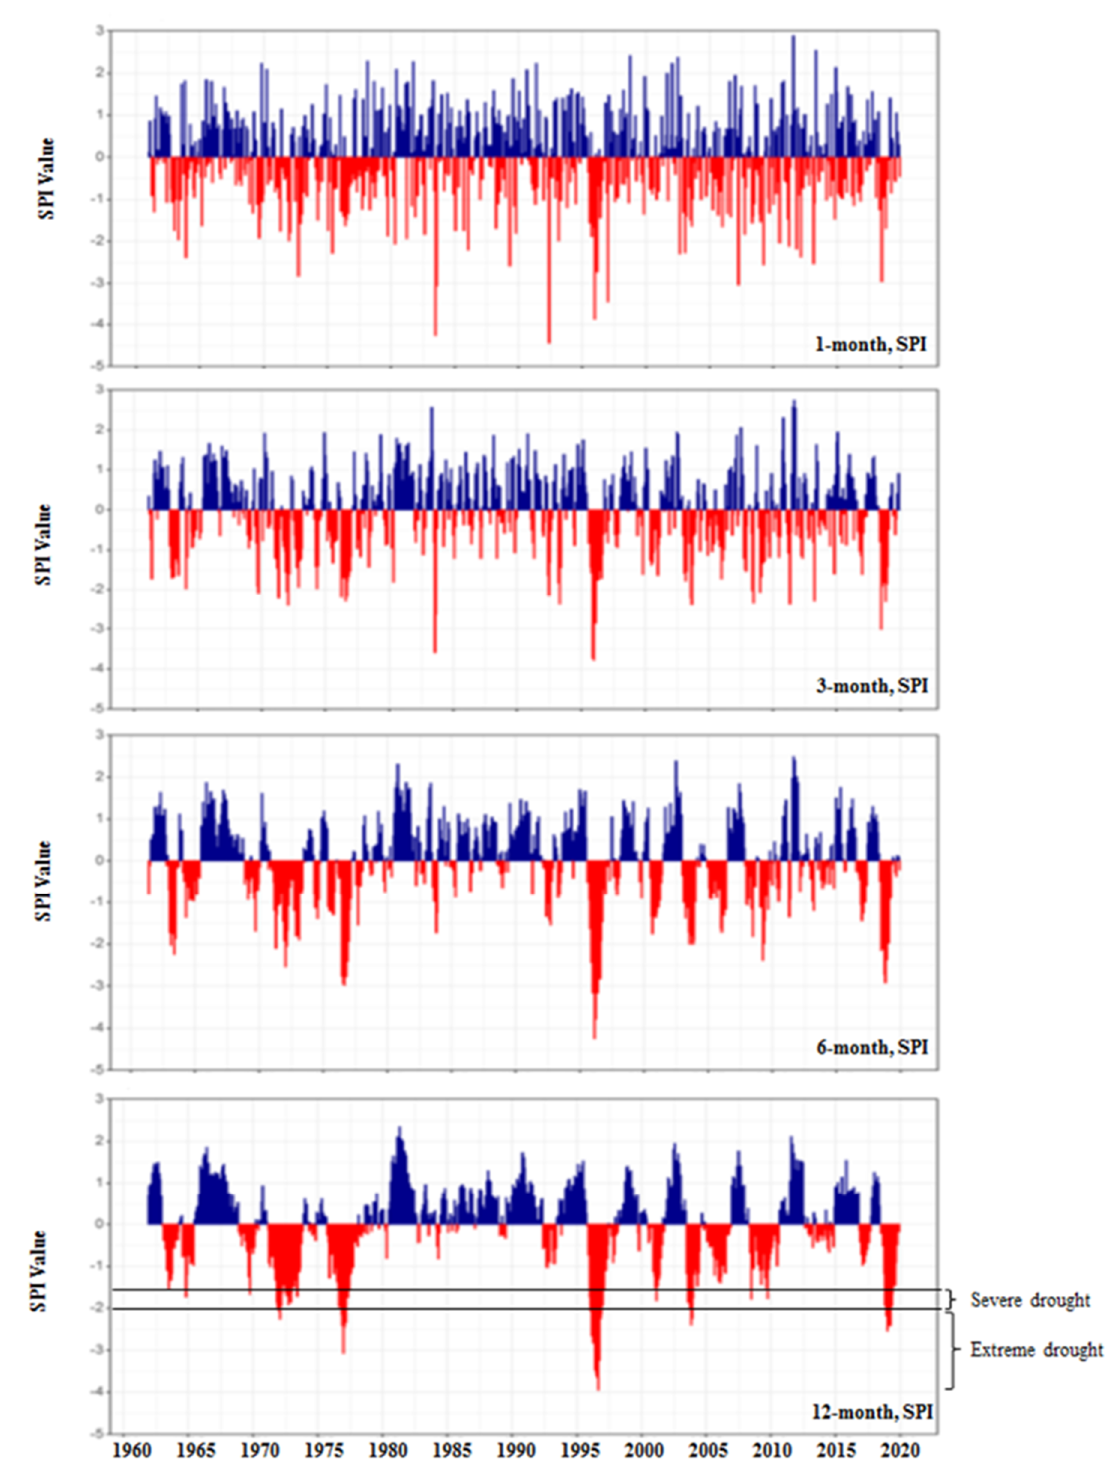
Figure 5. Time series of SPI-1, SPI-3, SPI-6, and SPI-12 at the Kiel-Holtenau synoptic station. The trend of De Martonne aridity index (I DM ) values in the analyzed period (1961– 2019) was not significant but it represented a clear fluctuation (Figure 6). A maximum value of I DM occurred in 1980 (I DM = 53.9) and a minimum value occurred in 2018 (I DM = 26.1). The average of I DM for the estimated period was around 40, which indicates a very humid climate type for the study area (Table 1).